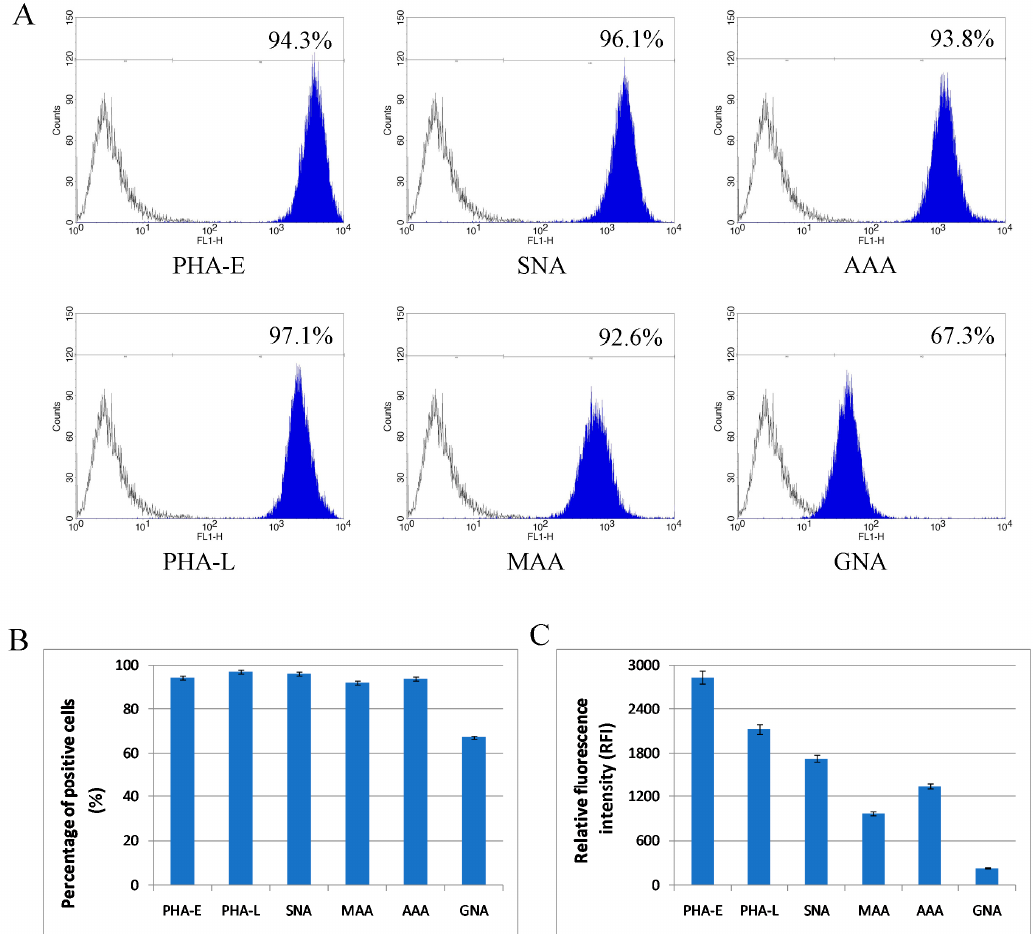
Figure 6. Flow cytometry analysis of surface glycosylation of Mel202 cells. ( A ) Histograms for MAA-, SNA-, GNA-, AAA-, PHA-E-, and PHA-L-positive cells. Colored areas represent staining with a panel of six lectins, while open histograms represent background fluorescence of the unspecific binding of extravidin-fluorescein isothiocyanate (FITC). The x-axis shows log fluorescence intensity and the y-axis shows the number of events. ( B ) Diagram showing the percentage of positive cells in each staining. ( C ) Diagram showing the relative fluorescence intensity (RFI) for each staining.